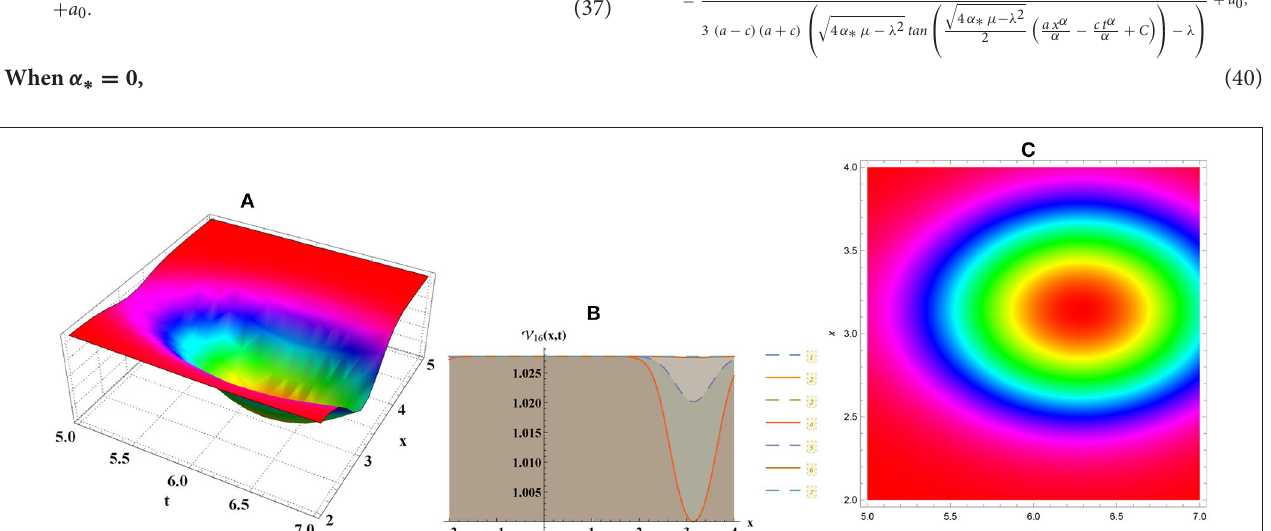
FIGURE 6 | Dark cone numerical graph for Equation (22) through (A) three-dimensional, (B) two-dimensional, and (C) density plots.